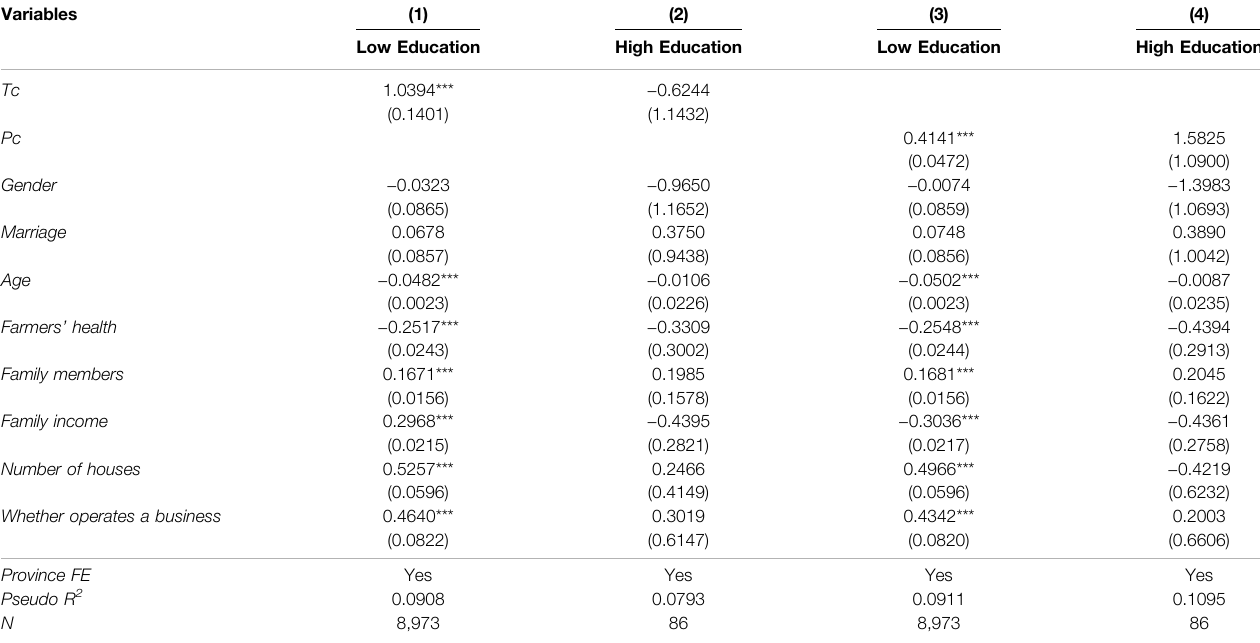
TABLE 9 | Heterogeneity of